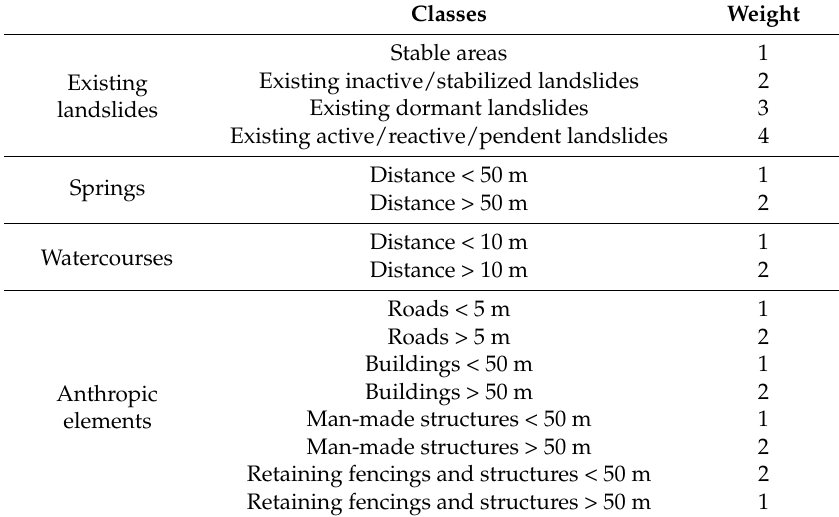
Table 8. Weights associated with each unit in the thematic maps, based on the incidence of landslides in the different categories. For existing landslides, springs, watercourses and anthropic elements, scores ranged from 1 (low incidence of landslides) to 2 or 4 (high incidence of landslides), depending on the number of adopted classes.